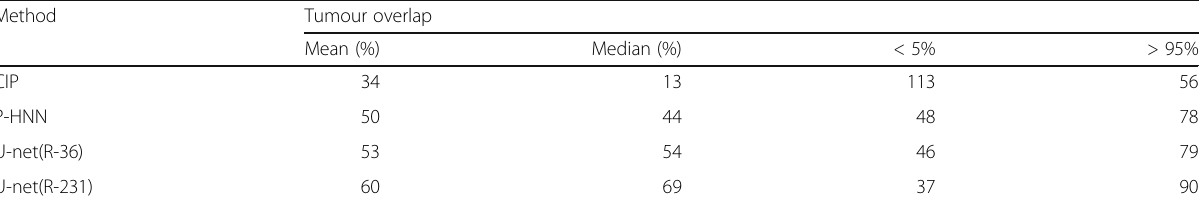
Mean, median, and number of cases with a smaller than 5% overlap and a larger than 95%